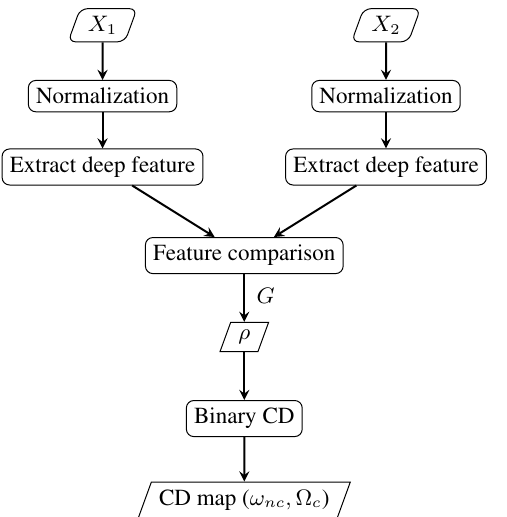
Figure 1. Method for obtaining CD map using a single untrained model. The ρ , ω nc , Ω c are used for decision fusion while combining multiple-trained models.